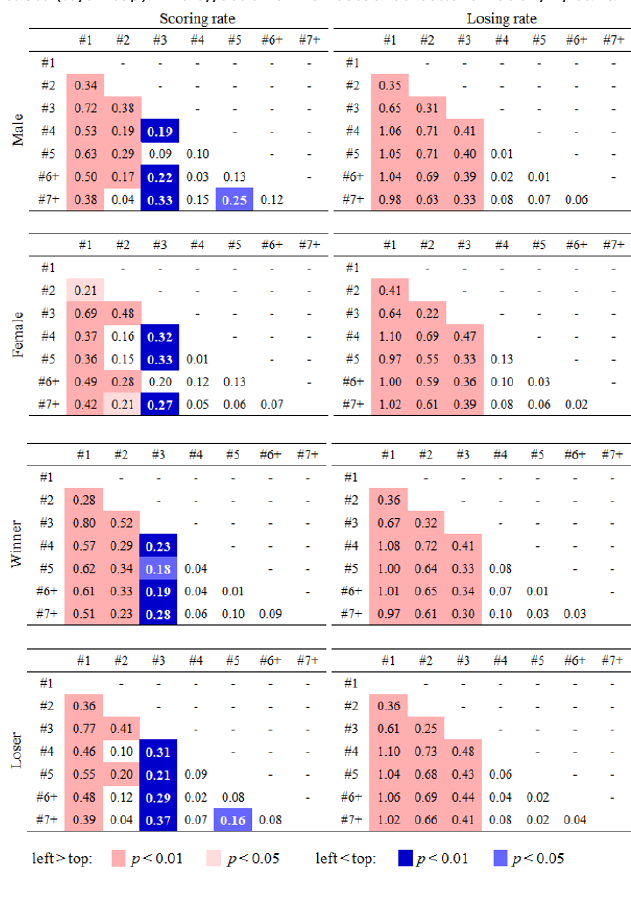
Table 3. Effect size between two different shot numbers calculated through the multiple comparisons of scoring rate and losing rate based on shot numbers. The tables show the results for each gender and for winners and losers. The filled colour of each cell denotes the correct- ed p-value calculated by pairwise comparison as described at the bottom of the table with pink cells denoting that the shot indicated at the left of the table is greater than the shot indicated at the top of the table (denoted as left > top) while the blue cells indicate that the shot at the left of the of the table is less than that at the top of the table (left < top). The effect size in uncoloured cells is not